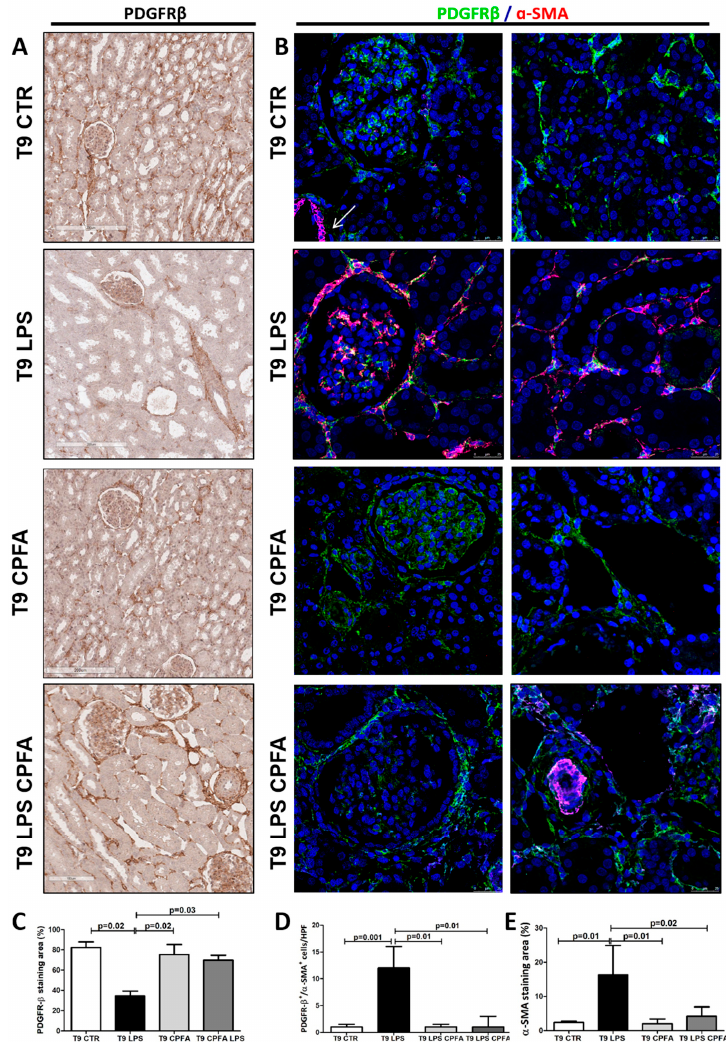
Figure 1 . CPFA inhibited LPS-induced PDGFR β down-regulation and pericyte-to-myofibroblast Figure trans-differentiation (PMT) in endotoxemic pigs. ( A ) IHC (Immunohistochemistry) revealed a strong decrease in PDGFR β expression at perivascular level after 9 h from LPS infusion (T9 LPS) compared to control (T9 CTR) and CPFA-treated healthy pigs (T9 CPFA). Renal biopsies of endotoxemic animals after CPFA treatment showed a preservation of PDGFR β + cells (T9 LPS CPFA) Magnification 10x. ( B ) Pericytes were double-stained for PDGFR β (green) and α -SMA marker (red) to further demonstrate